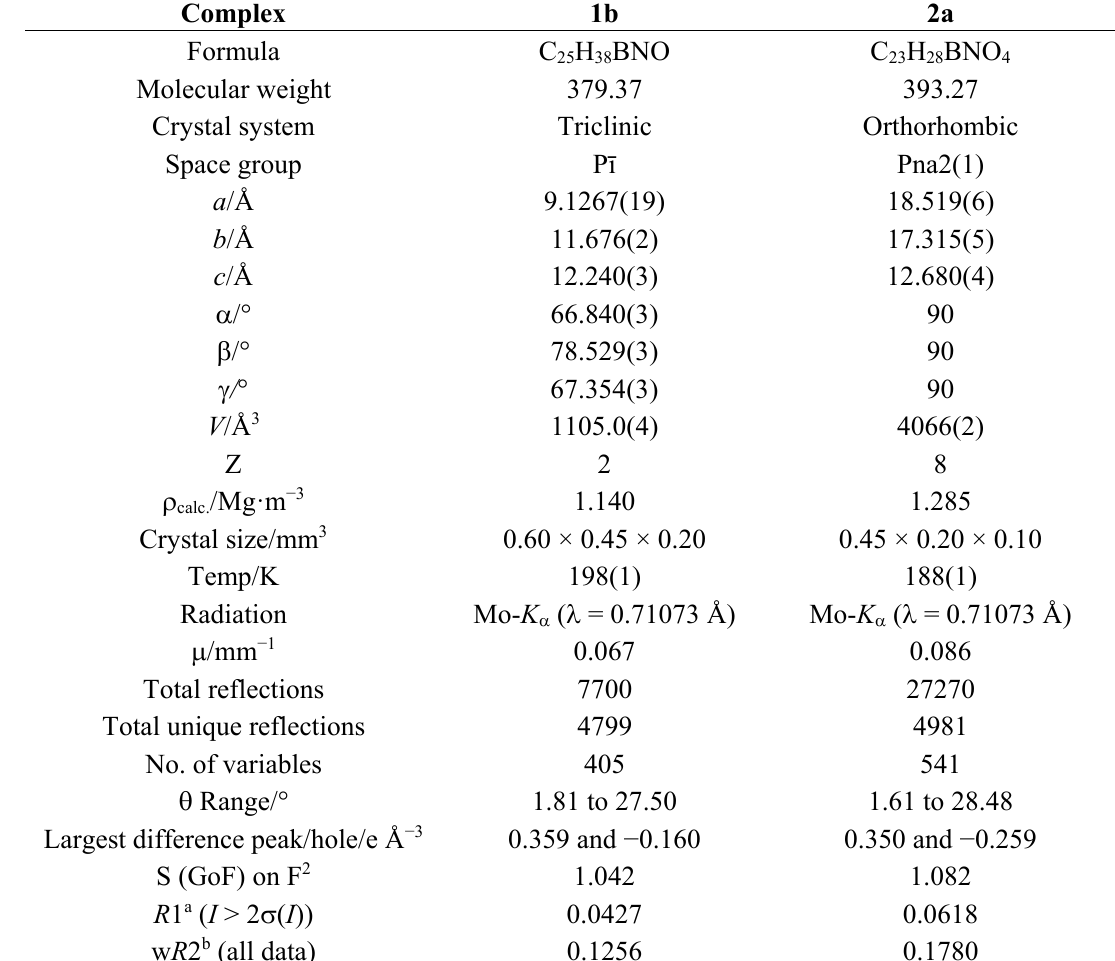
Table 1. Crystal data and structure refinement details for compounds 1b and 2a